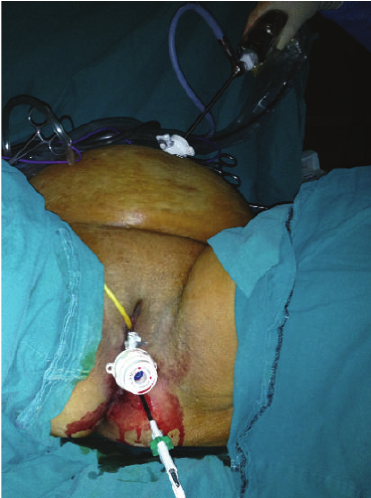
Figure 2: Transumbilical 5 mm, 30 ∘ laparoscope and perineal view.